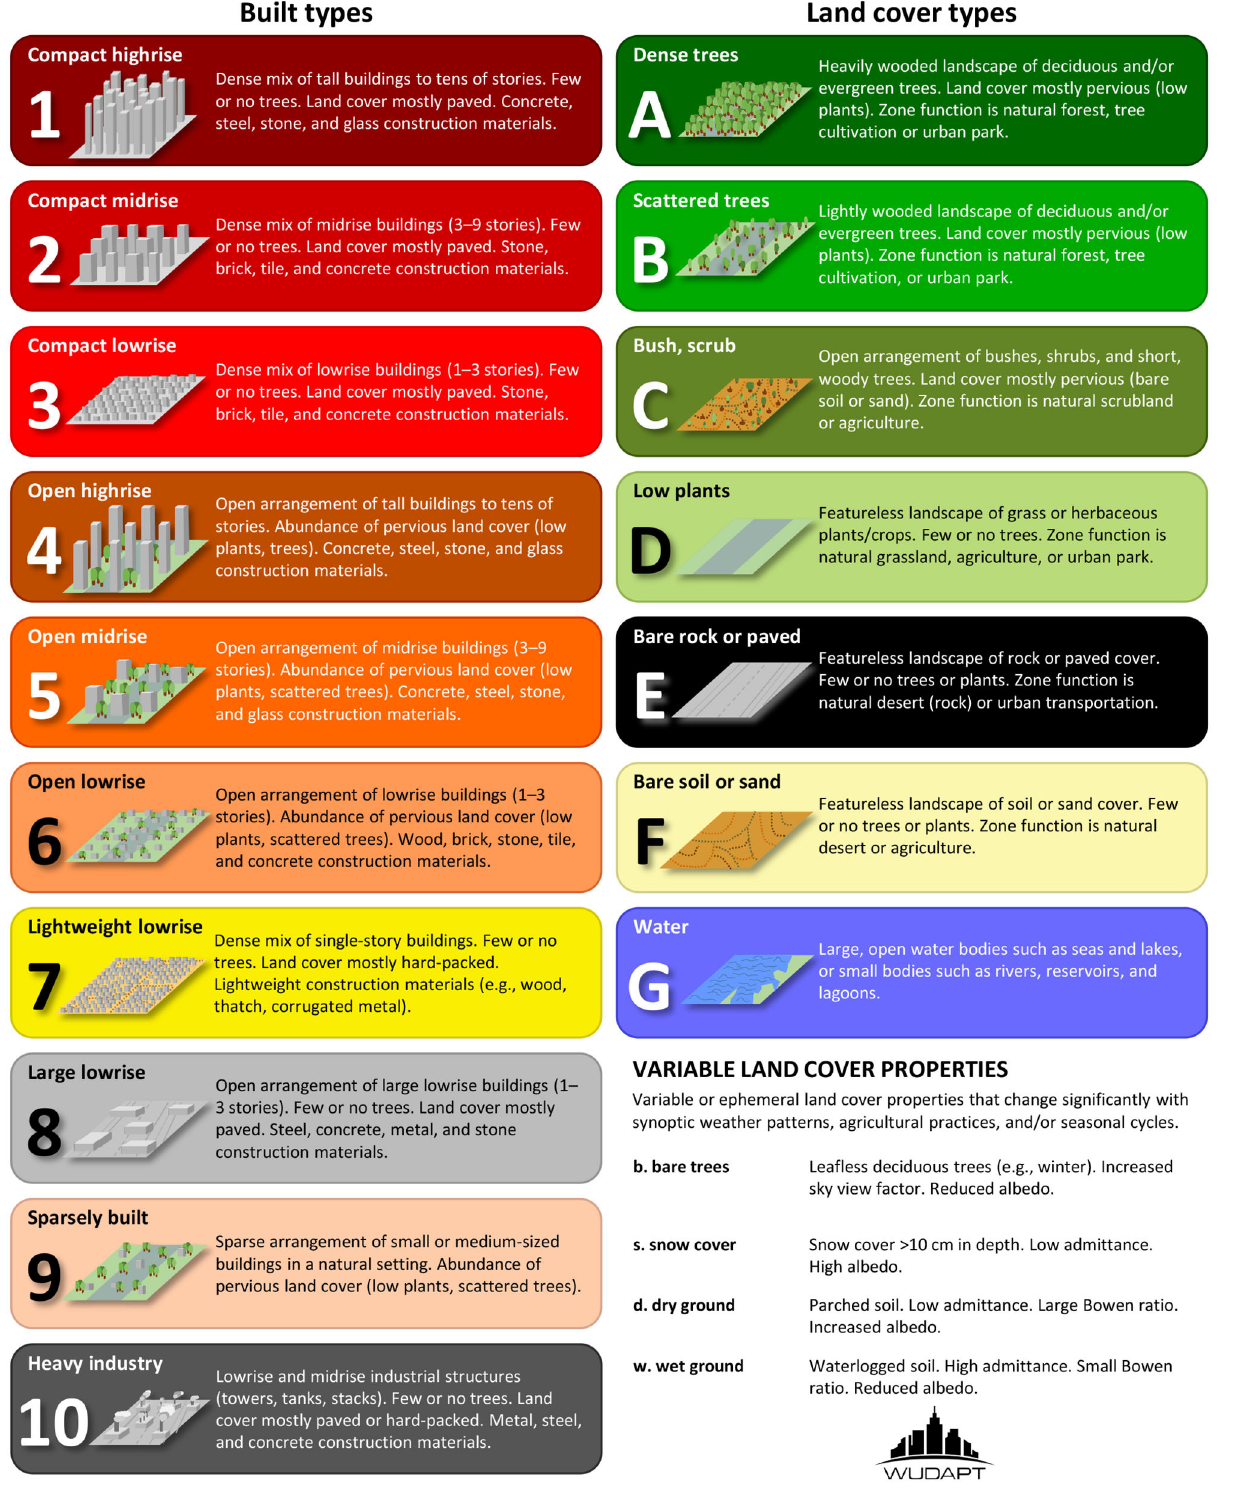
FIGURE 1 | Urban (1–10) and natural (A–G) Local Climate Zone definitions (Stewart and Oke, 2012; Demuzere et al., 2020a).